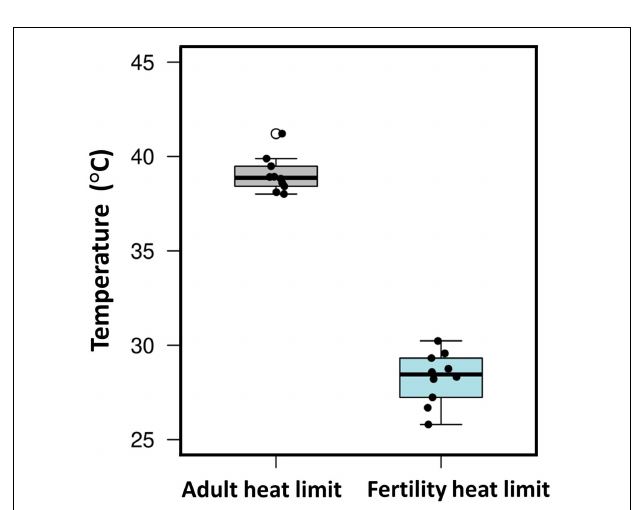
FIGURE 4 | Male fertility is more sensitive to heat than adult thermal tolerance. Box plot showing male fertility thermal limits (FTLs) and critical thermal maximum (CTmax) from 10 Drosophila species (data from van Heerwaarden and Sgrò, 2021). Boxes include the interquartile range, the whiskers span the range of the data, and the thick bars indicate the median values. Each point refers to data for a single